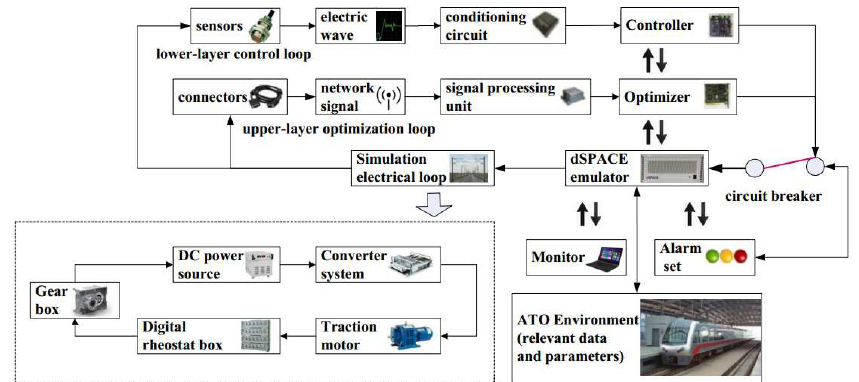
Figure 9. The structure diagram for automatic train operation